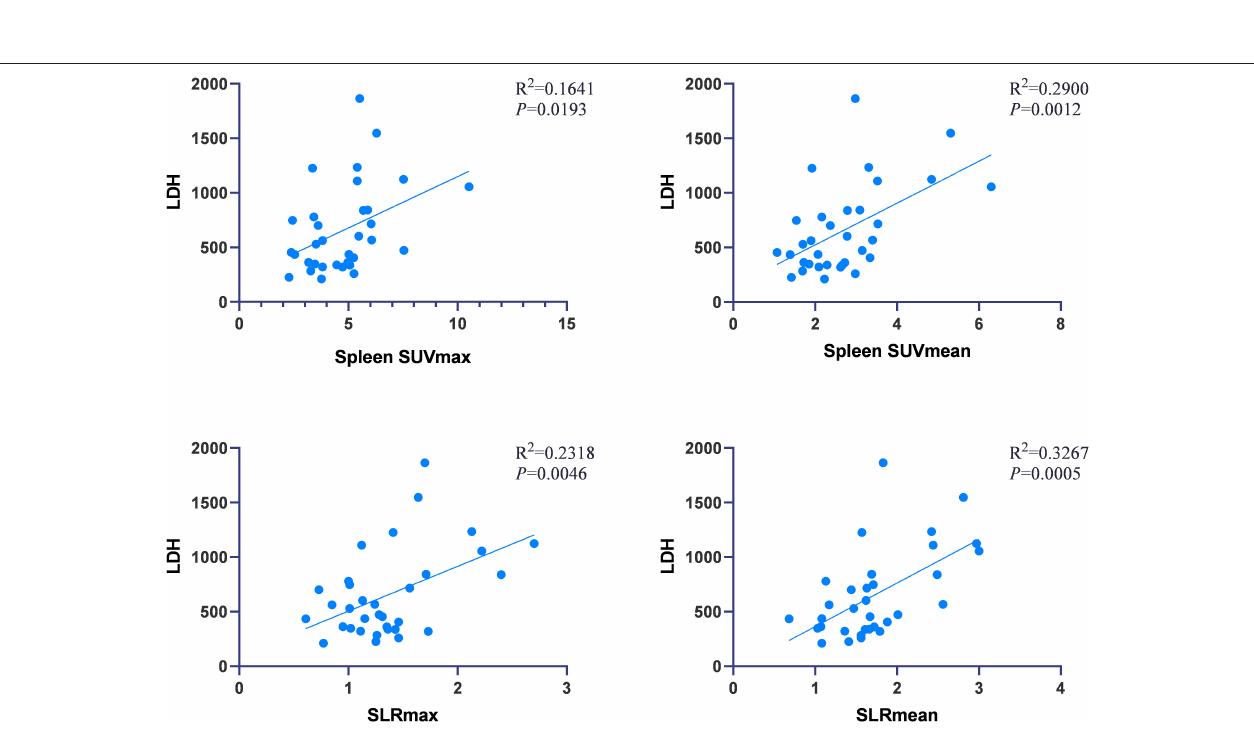
FIGURE 4 | LDH was positively correlated with spleen SUVmax, spleen SUVmean, SLRmax, SLRmean, and LDH ( P < 0.05).